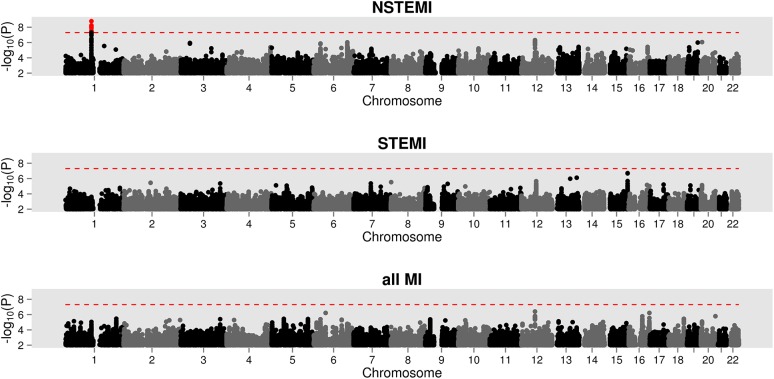
Summary of the genome-wide association results comparing healthy controls with only NSTEMI, only STEMI, or all acute MI cases.Variants reaching the genome-wide significance threshold P < 5 × 10−8, marked with the dashed line, are shown in red.